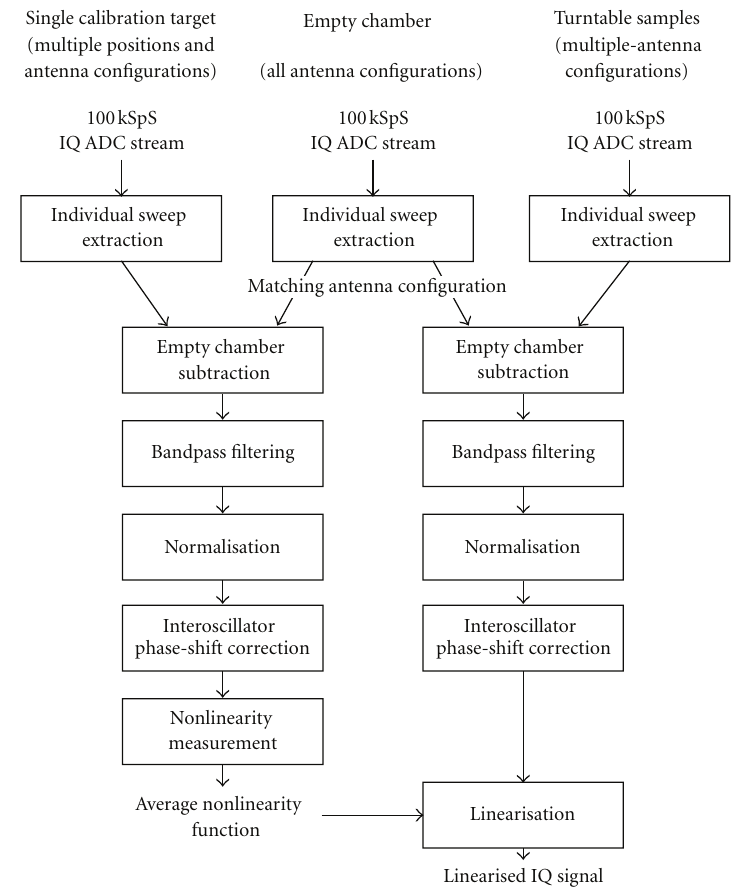
Figure 5: Flowchart of signal linearisation process.